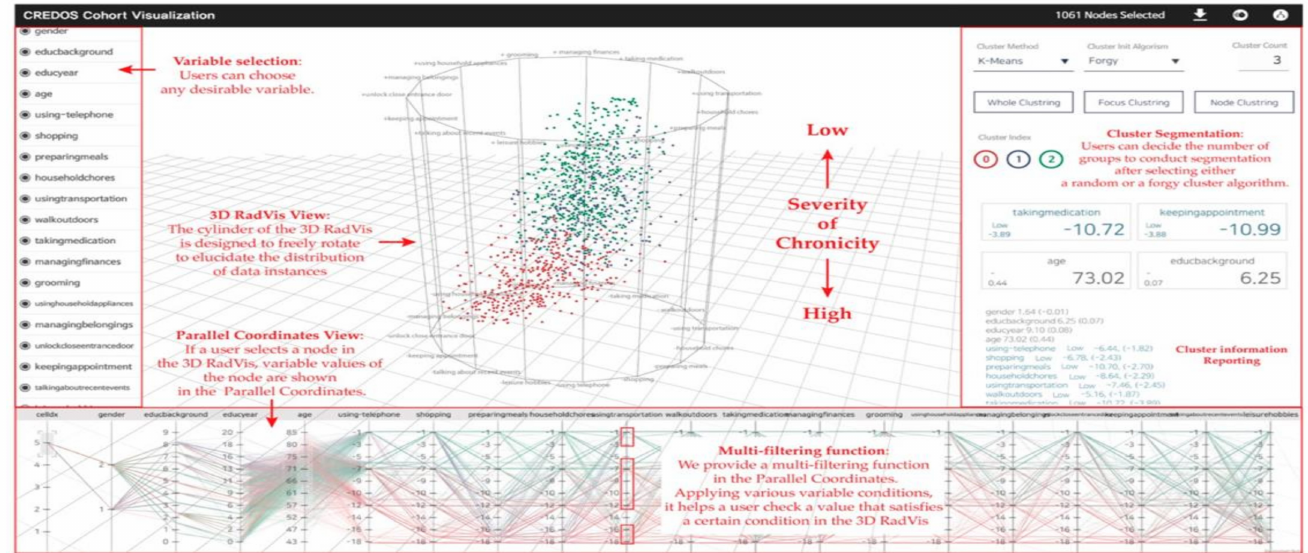
Figure 4. The screenshot of RadVis [39] combing 3D RadVis and parallel coordinates. Source: image used under CC-BY 4.0